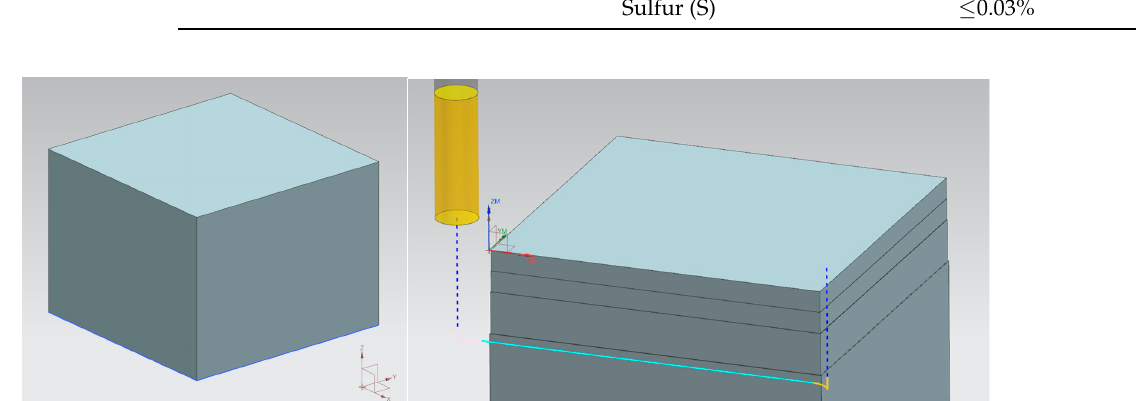
Figure 2. Workpiece and processing path. Table 2. Specification of the tool.